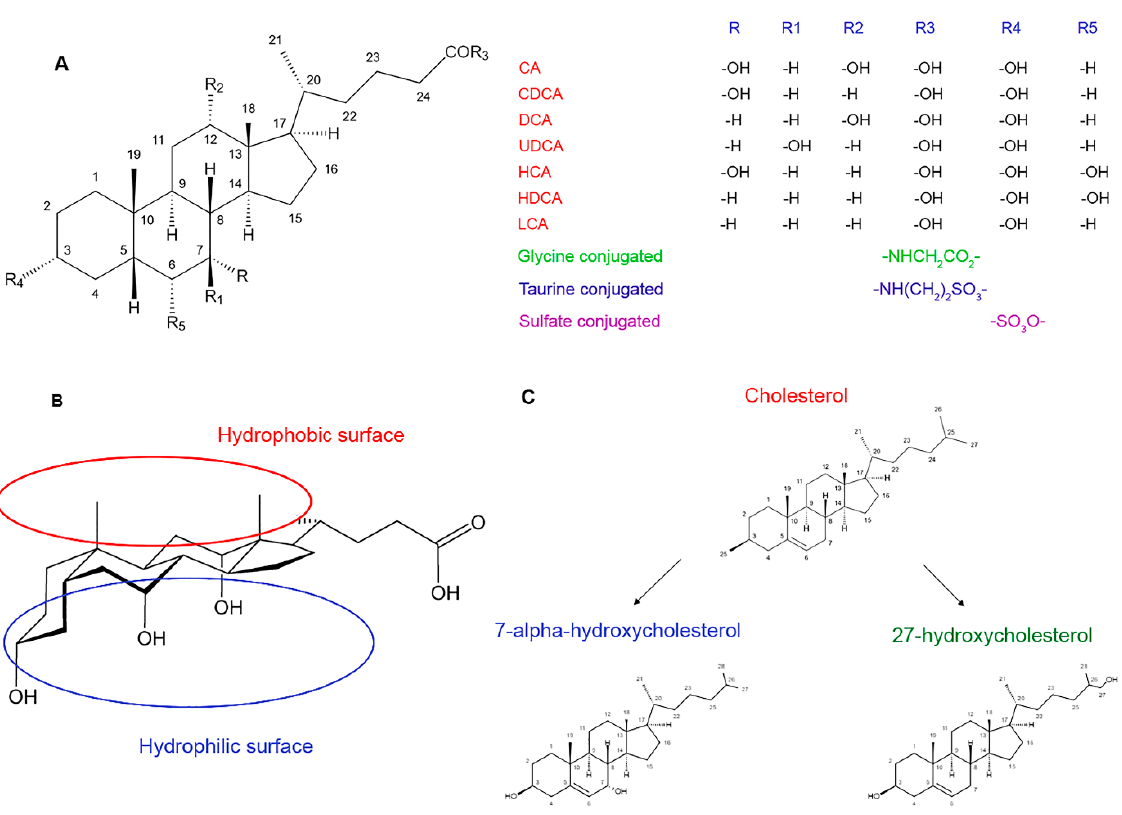
Figure 1. The chemical structure of bile acids. ( A ) The main structural formula of bile acids with subsequent radicals: CA, cholic acid; CDCA, chenodeoxycholic acid; DCA, deoxycholic acid; UDCA, ursodeoxycholic acid; HCA, hyocholic acid; HDCA, hyodeoxycholic acid; LCA, lithocholic acid. ( B ) Bile acids possess detergent activity due to the presence of hydrophobic chemical groups on the “upper” plain of their molecule and hydrophilic groups on the “bottom” plain. ( C ) Two ways of bile acids biosynthesis from cholesterol: “neutral” leading to 7 α -hydroxycholesterol and “acidic” leading to 27-hydroxycholesterol.